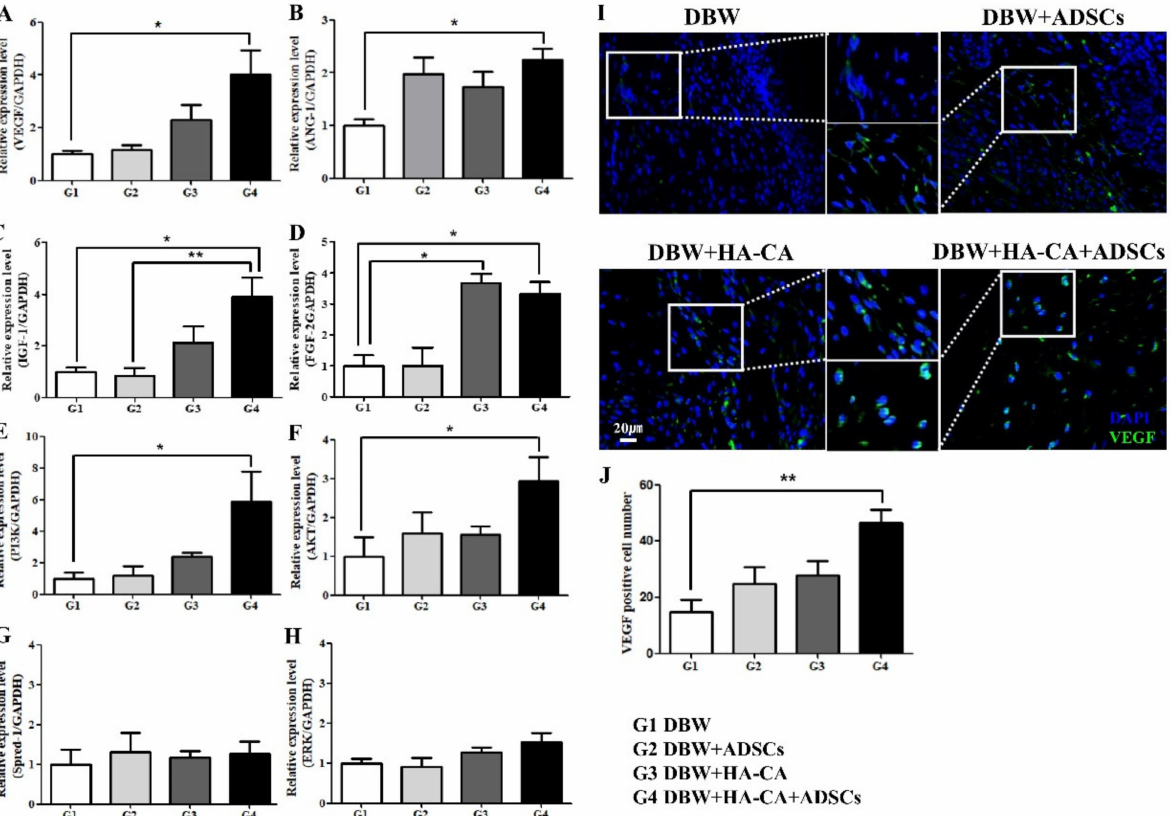
Figure 4. Effects of treatment with HA-CA and ADSCs on the angiogenesis-related gene expression profile. The mRNA levels of the angiogenesis-associated genes ( A ) VEGF , ( B ) ANG-1 , ( C ) IGF-1 , ( D ) FGF-2 , ( E ) PI3K , ( F ) AKT , ( G ) Spred1 , and ( H ) ERK were determined by quantitative real-time polymerase chain reaction (qRT-PCR). Data are presented as means ± SEM relative to GAPDH mRNA level (* p < 0.05, ** p < 0.01; n = 6 per group). ( I ) VEGF expression was assessed by immunofluorescence staining. VEGF expression was significantly increased in mice treated with HA-CA + ADSCs. ( J ) Bar graphs showing that mice in the HA-CA + ADSCs group had the greatest number of VEGF-positive cells (** p < 0.01, n = 8 per group). Magnification: × 400. VEGF, vascular endothelial growth factor; ANG-1, angiopoietin 1; IGF-1, insulin-like growth factor 1; FGF-2, fibroblast growth factor 2; PI3K, phosphoinositide 3-kinase; AKT, protein kinase B; Spred-1, sprouty- related EVH1 domain-containing 1; ERK, extracellular signal-regulated kinase; GAPDH, glyceraldehyde-3-phosphate